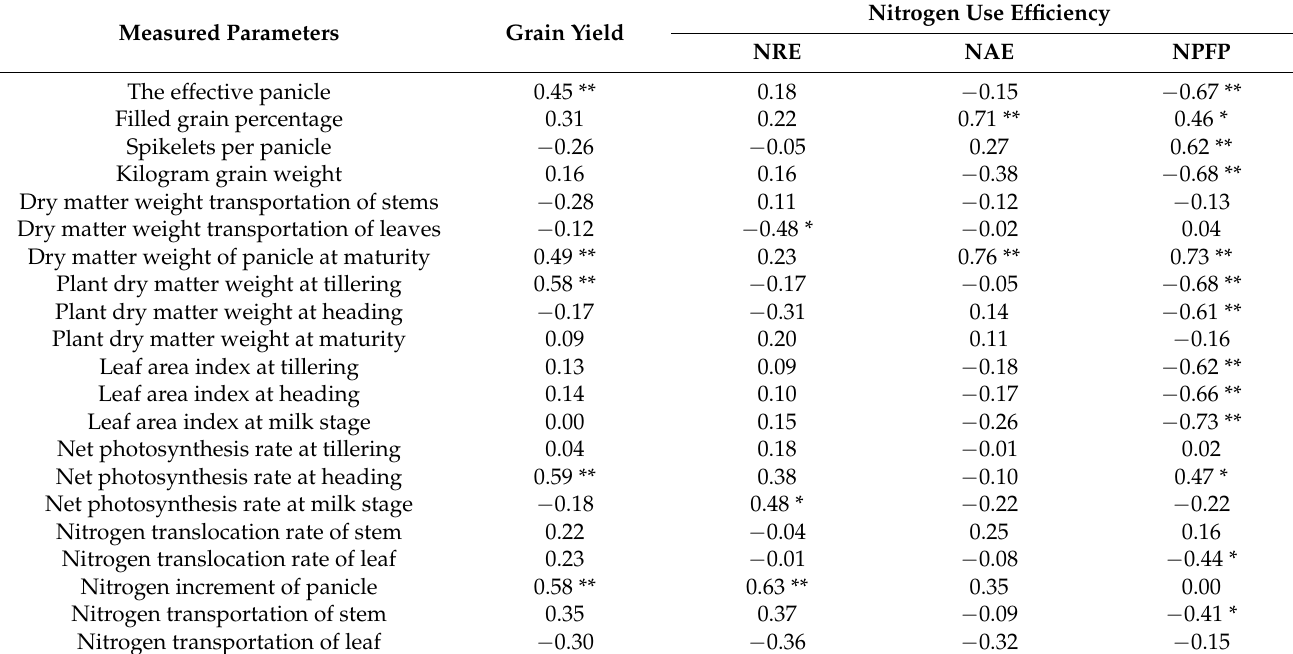
Table 8. Correlations between the measured parameters and grain yield and nitrogen use efficiency for grain yield of